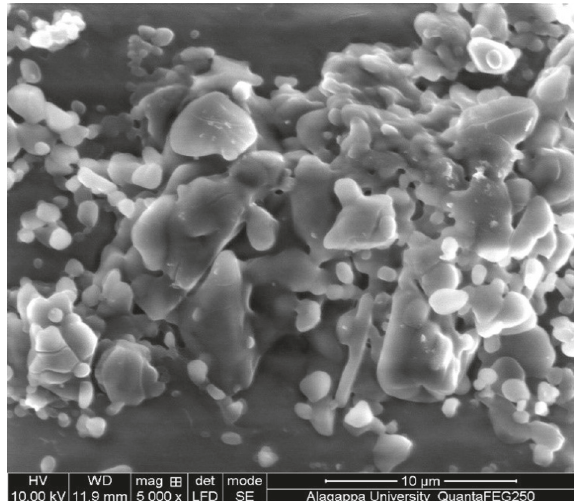
Figure 6: UV-visible absorbance spectra of